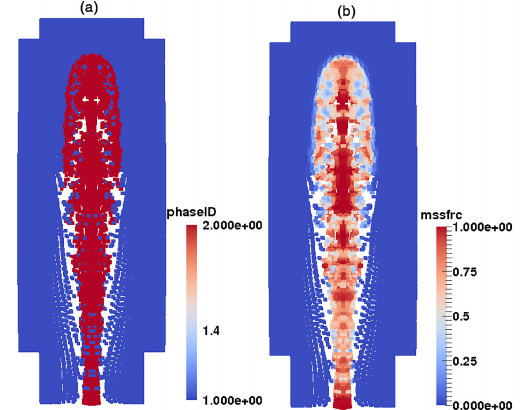
Figure 9. Panel (a) shows particle distribution. Particles of phase 1 (blue) are gradually entrained and mixed with erupted particles (red) as jet flows downstream. Panel (b) shows the mass fraction of erupted material at the moment corresponding to panel (a) .